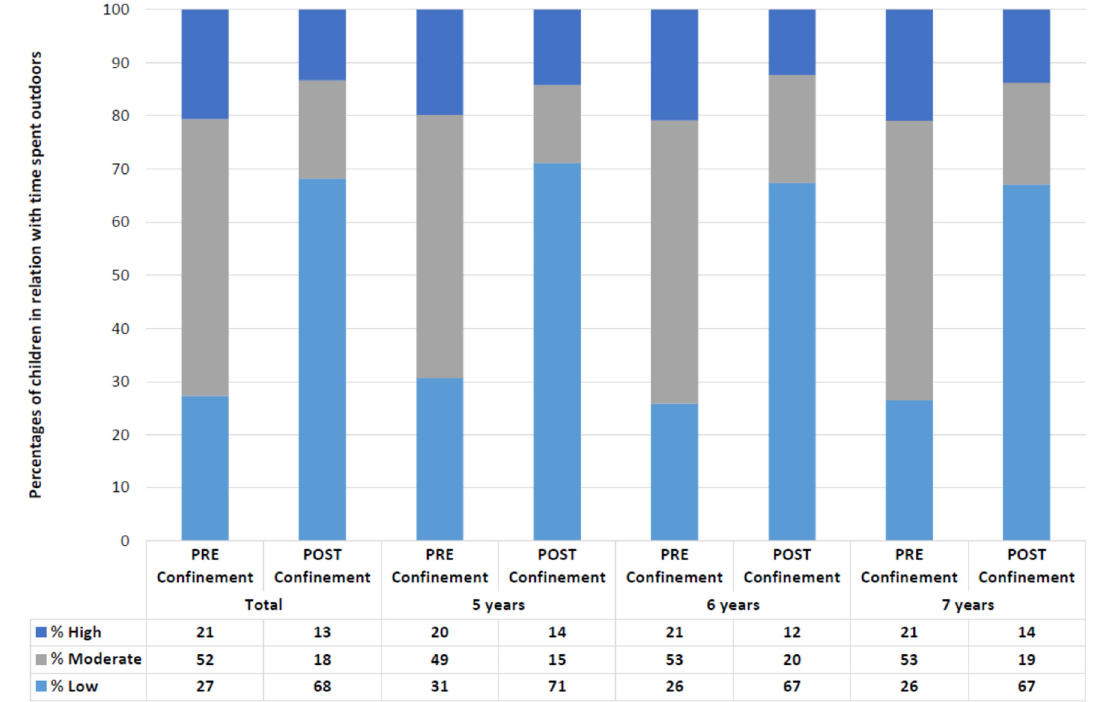
Figure 3. Classification of children depending on the time they spent outdoors in all samples and by ages (Low: <1.6 h a day; Moderate: 1.6–2.7 h a day; High: >2.7 h a day).